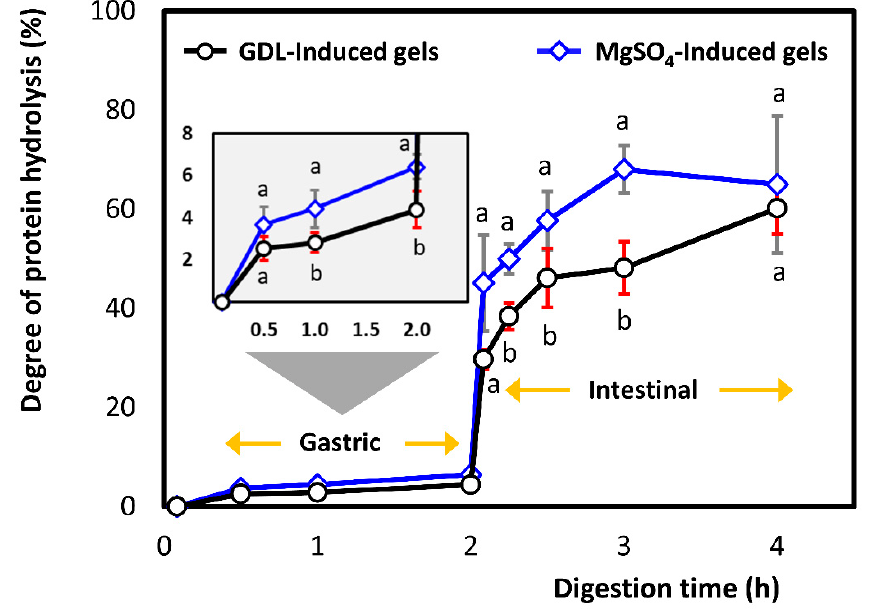
Figure 4. Degree of protein hydrolysis (%) of pressed gels (control) induced by GDL ( ○ ) and MgSO 4 ( ◊ ) during in vitro simulation of digestion. The values were represented as means ± standard deviations ( n ≥ 3). Different letters indicate significant differences ( p ≤ 0.05).